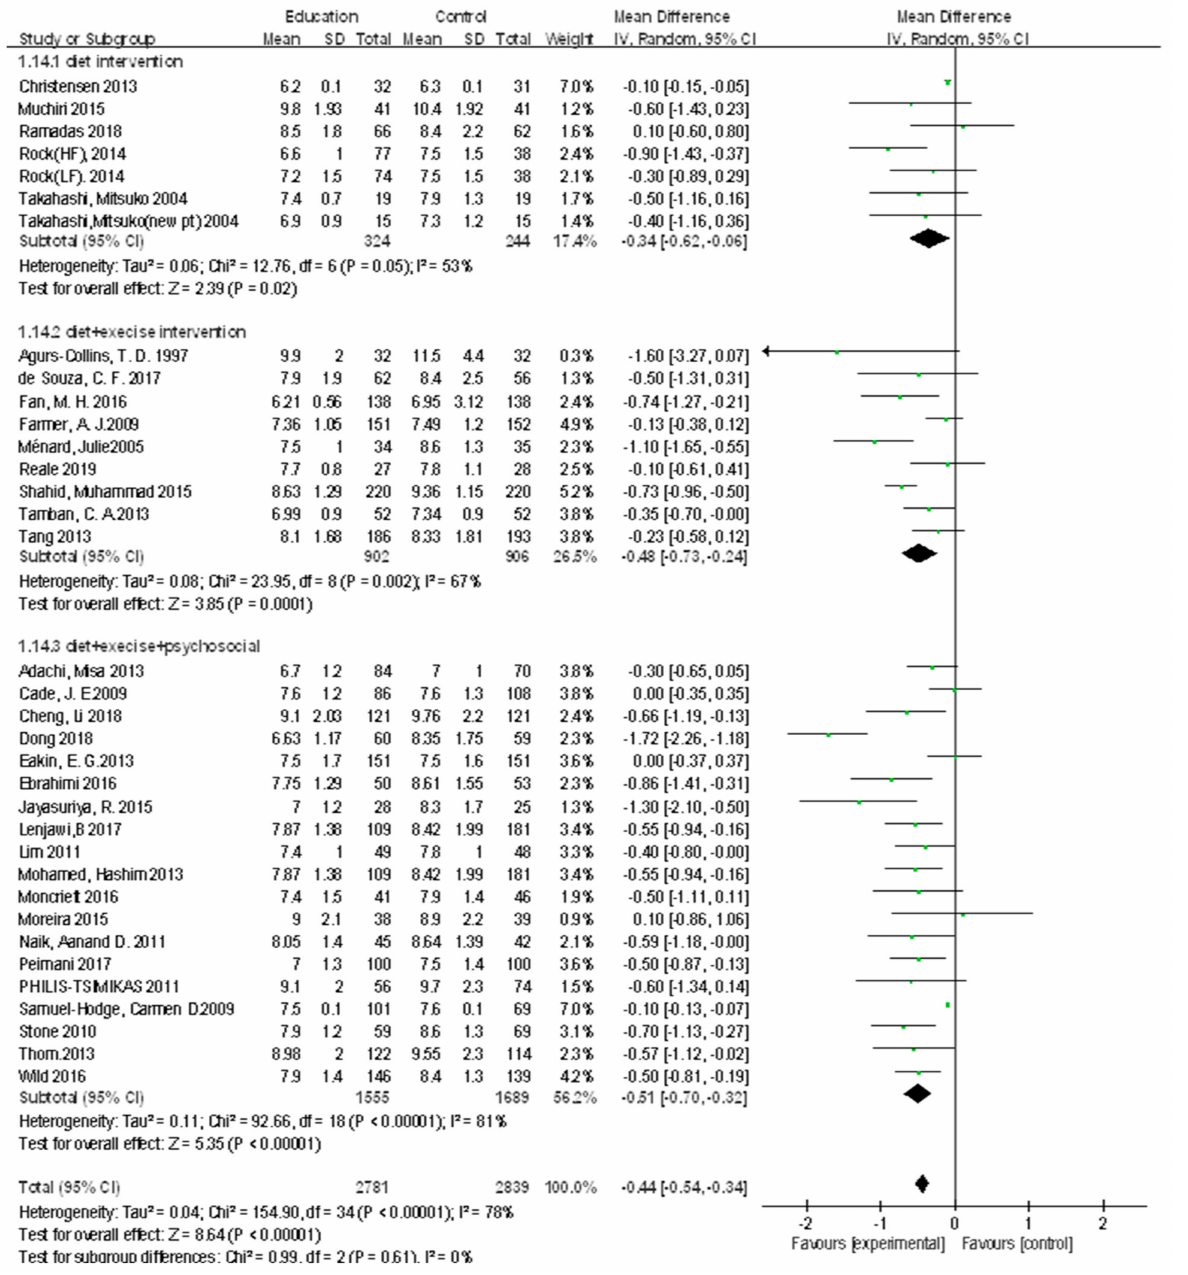
Figure 6. Forest plot of the effect of diet education. SD, standard deviation; CI, confidence interval; IV, inverse